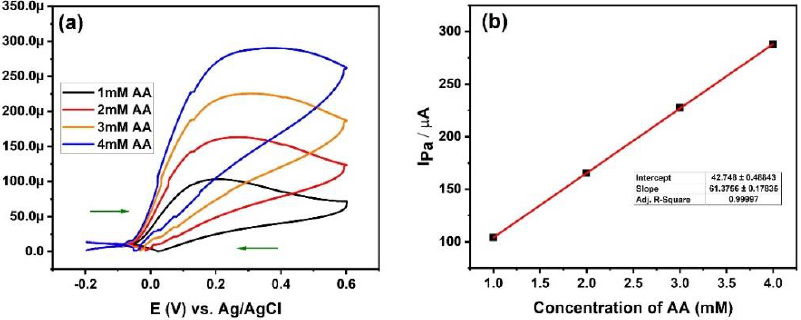
Figure 10. ( a ) CV curve of AA at different concentrations. ( b ) Plot of Ipa vs. the concentration of